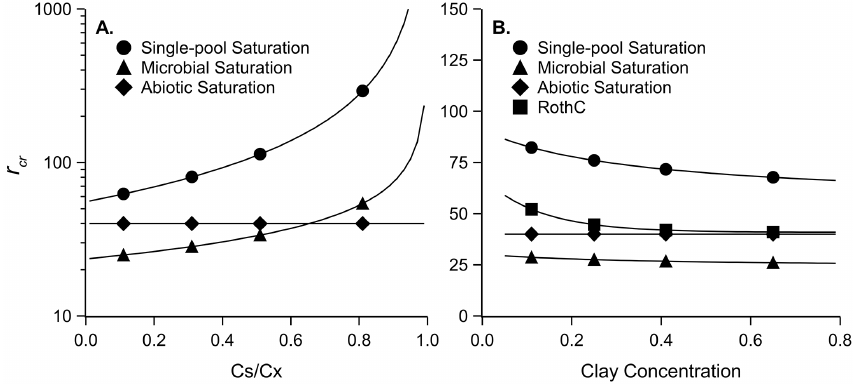
Figure 4. The critical C:N ratio ( r cr ) as a function of carbon saturation ratio (a) and clay concentration (b) . In (b) , the pool size for C s was maintained constant at 32MgCha − 1 ; thus, the clay gradient creates a C saturation gradient. For reference, a pool size of 32MgCha − 1 would result from an annual C input level of ∼ 5MgCha − 1 y − 1